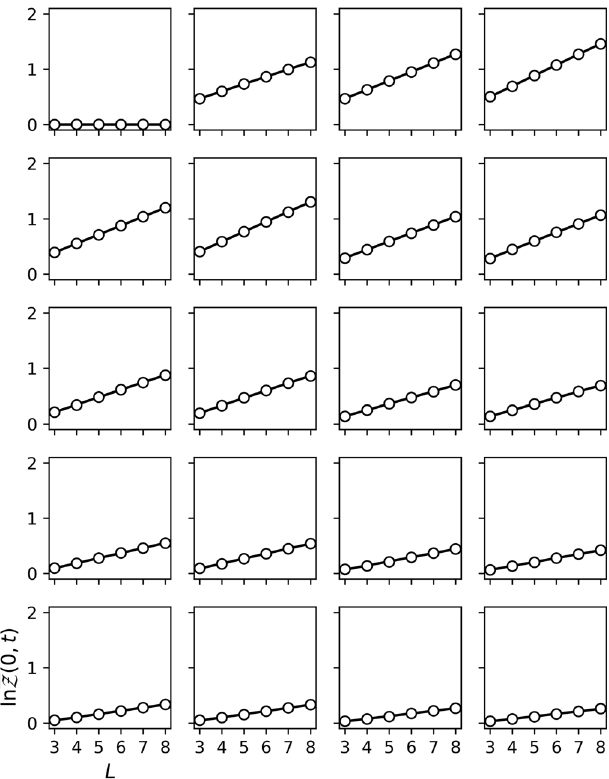
¯ Z ð ω ; t Þ FIG. 32. Scaling of ln with L as in Fig. 31, here for ω ¼ 2 π =t